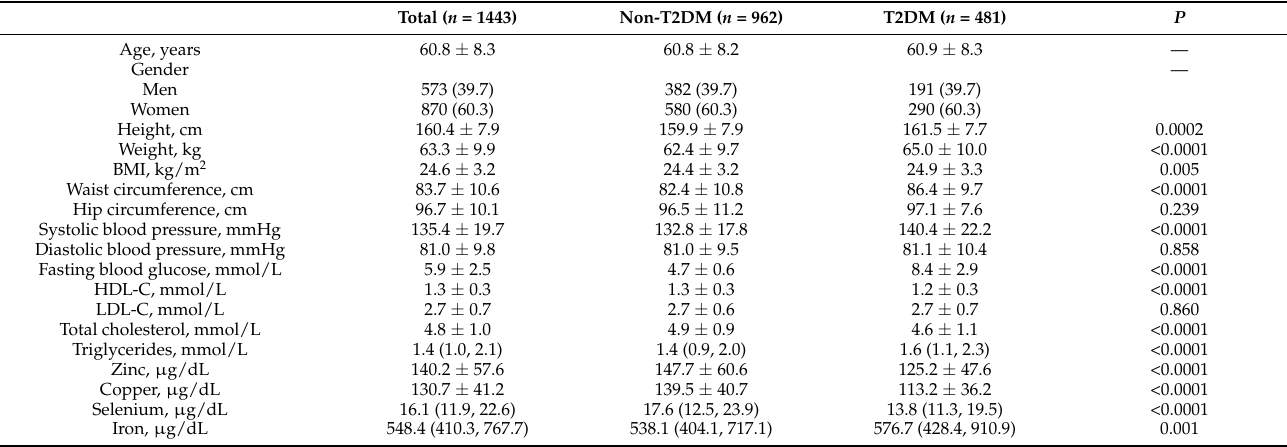
Table 1. Characteristics of the participants by case-control